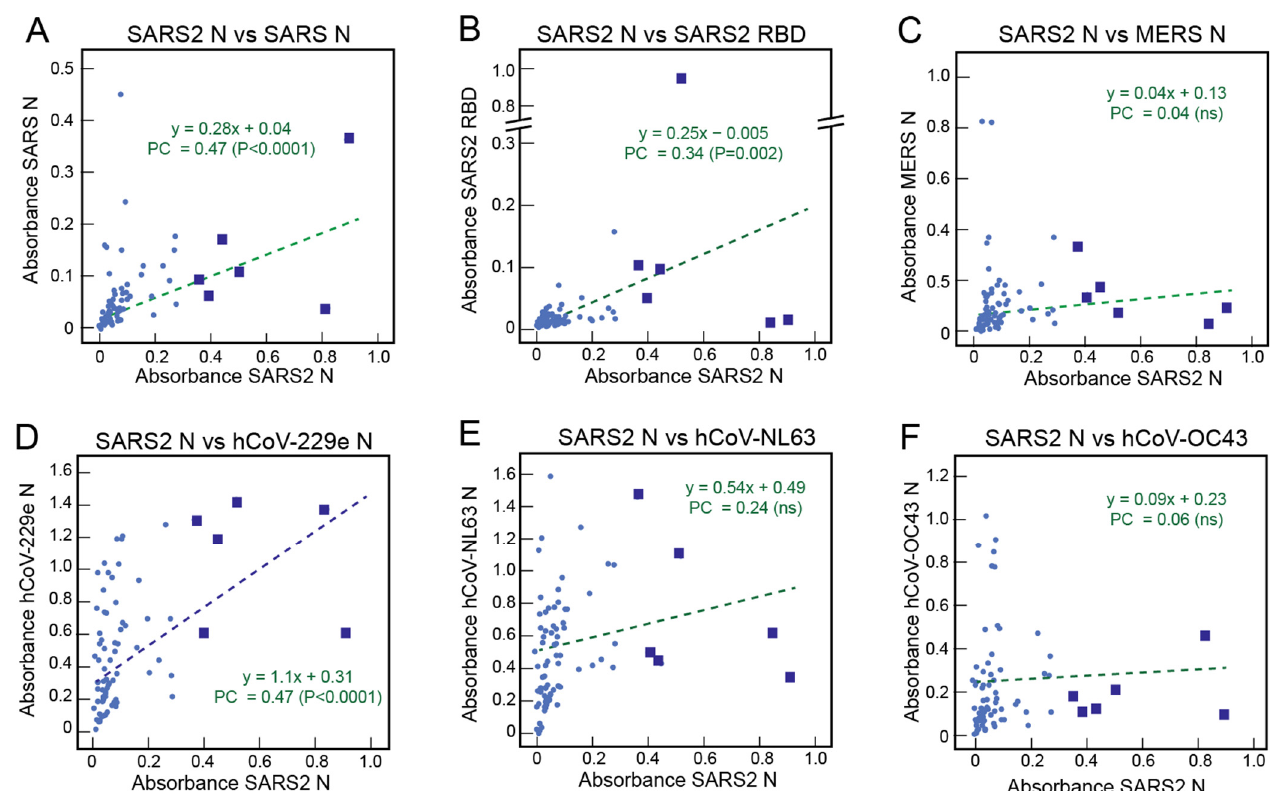
Figure 5. Correlations of the serological responses of United States normal blood donors to coronavirus antigens. Binding of IgG in serum or plasma samples (1:100 dilution) from United States normal blood donors was quantified using ELISA coated with recombinant coronavirus proteins. Reactivity to SARS-CoV-2 N was compared to other coronavirus proteins in each panel: ( A ) SARS-CoV N, ( B ) SARS-CoV-2 RBD, ( C ) MERS-CoV-N, ( D ) hCoV-229E N, ( E ) hCoV-NL63 N, and ( F ) hCoV-OC43 N. Dotted lines are linear regression plots of seroreactivity of SARS-CoV-2 N versus other recombinant coronavirus proteins. PC = Pearson’s correlation.